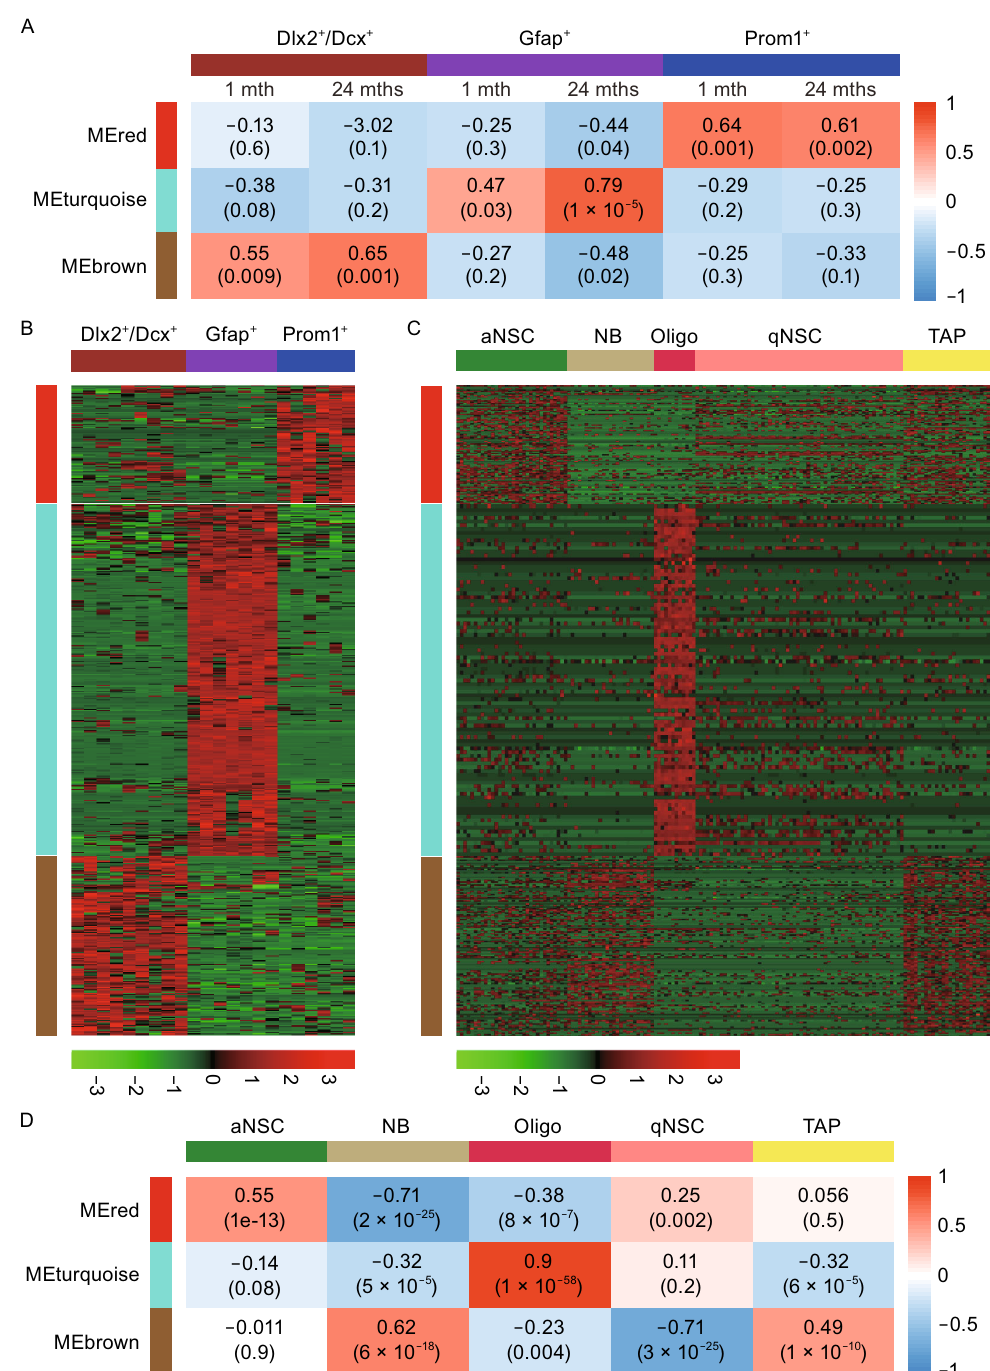
Figure 5. NSC/NPC subtype identi fi cation of 22 sequenced single cells based on transcriptome analyses. (A) WGCNA revealed three speci fi c gene modules (red, turquoise, and brown), demonstrating enrichment in Prom1 + , Gfap + , and Dlx2 + /Dcx + cells populations. (B) Heatmap of genes of red, turquoise, and brown modules in 22 sequenced single cells. (C) Cross-referencing gene expression of red, turquoise, and brown identi fi ed from our 22 single cell transcriptome, in published data set by Llorens-Bobadilla et al. in Cell Stem Cell (2015). (D) Correlations between the three modules with 5 published cell types by Llorens-Bobadilla et al. (2015, Cell Stem Cell